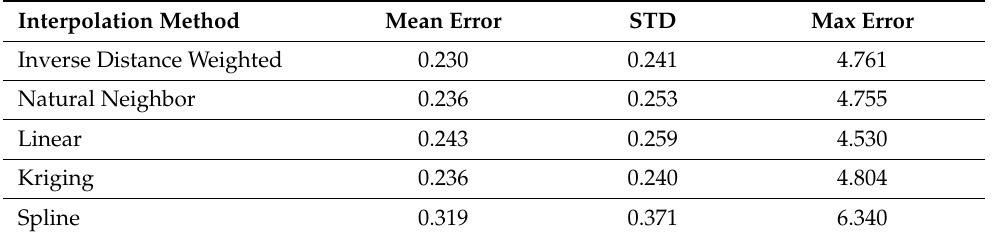
Figure 9. Explanation of disturbances in the measurements at the control station of Dzie ć kowice, January 2015: numbers are monthly sums of precipitation in control stations. Table 2. General summary of results for all control stations in all months of the period